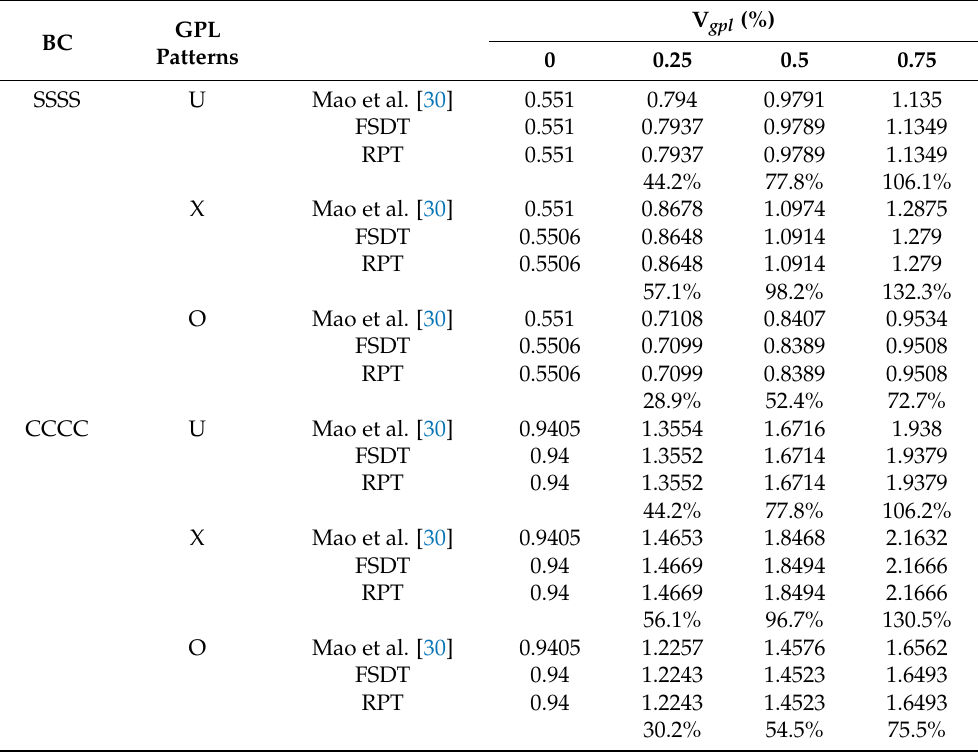
Table 3. Dimensionless frequency of the FG-GRP plates with different graphene volume fraction and different distribution patterns under different boundary conditions.